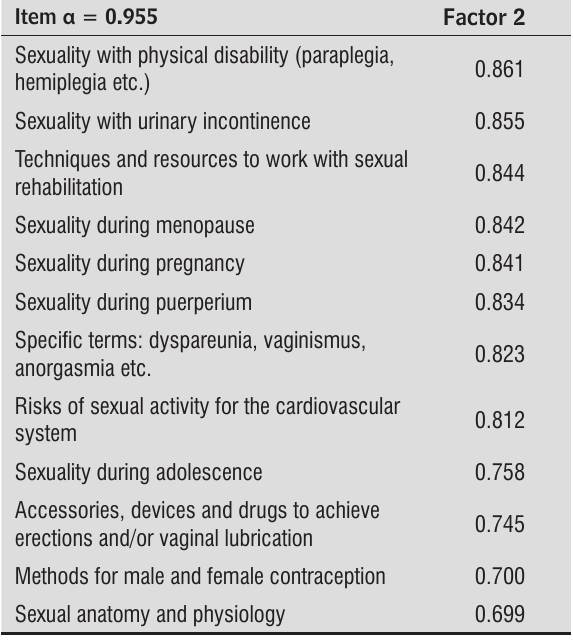
Table 2 - Factor analysis from the extraction of the comfort